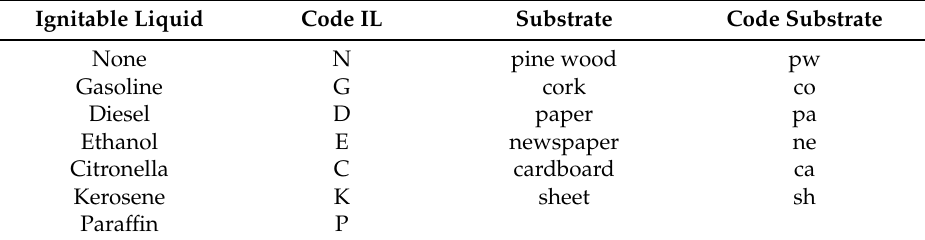
Table 1. Ignitable liquids and substrates used for the preparation of burned samples. Ignitable